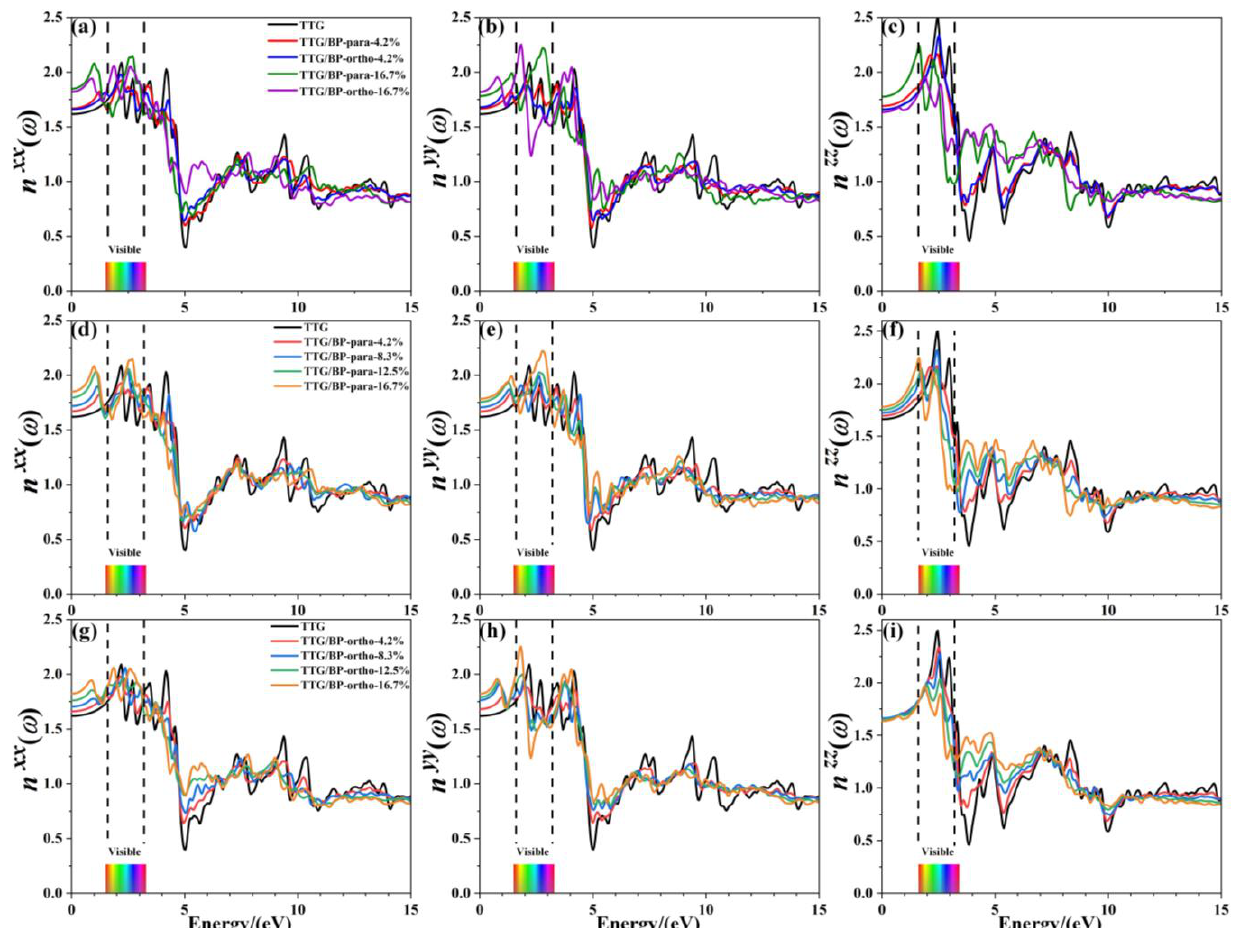
Figure 10. Refractive index of TTG/BP systems. ( a ) n xx of TTG/BP; ( b ) n yy of TTG/BP; ( c ) n zz of TTG/BP; ( d ) n xx of TTG/BP-para; ( e ) n yy of TTG/BP- para; ( f ) n zz of TTG/BP- para; ( g ) n xx of TTG/BP-ortho; ( h ) n yy of TTG/BP-ortho; ( i ) n zz of